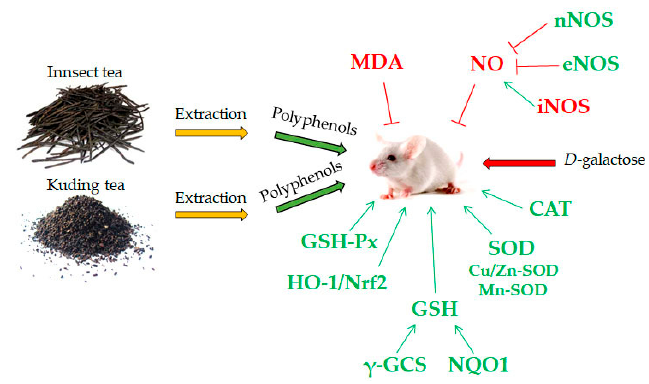
Figure 12. The observed effects in this study.